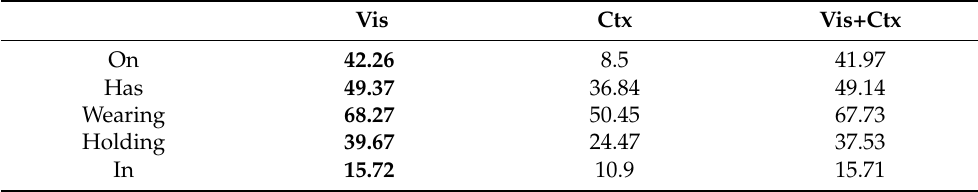
Figure 7. Comparison of the R@100 values of different models on the test set for various types of relationships in the SGDet task. The X -axis represents the common relationship categories in the dataset, and the Y -axis represents the R@100 values. Table 9. R@100 values of each model for selected relationship categories in the SGDet task.